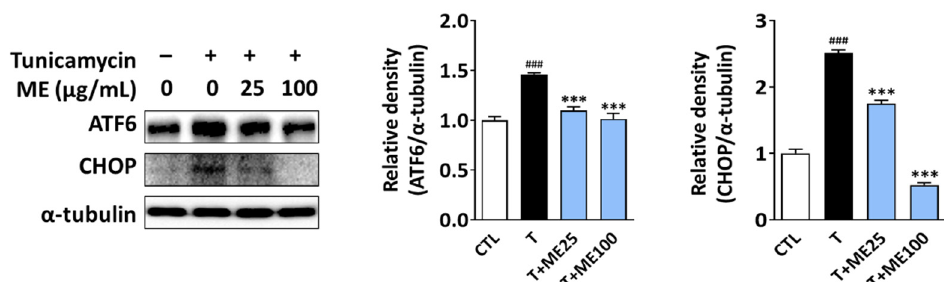
Figure 5. Effect of ME on ER stress signals. NIT-1 pancreatic β -cells were treated with ME alone (0, 25, or 100 µ g/mL), followed by tunicamycin (0.05 µ g/mL) co-treatment. The levels of ER stress-related proteins (ATF-6 and CHOP) were examined using Western blotting. Band density was quantified using ImageJ software. Results are represented as the mean ± SD of three separate experiments performed in triplicate. ### p < 0.001 versus CTL (vehicle-treated cells); *** p < 0.001 versus tunicamycin-treated cells. ROS: reactive oxygen species; T: tunicamycin; ME: Mori Ramulus ethanol ex- tract.